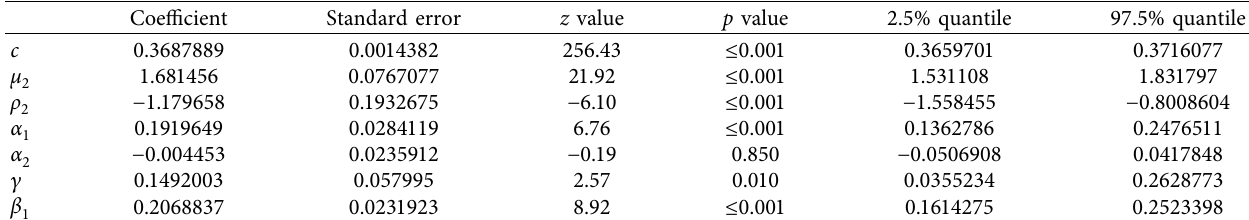
Table 5: The relationship between unexpected trading volume and open interest and price fluctuations in China’s soybean futures market. Coefficient Standard error